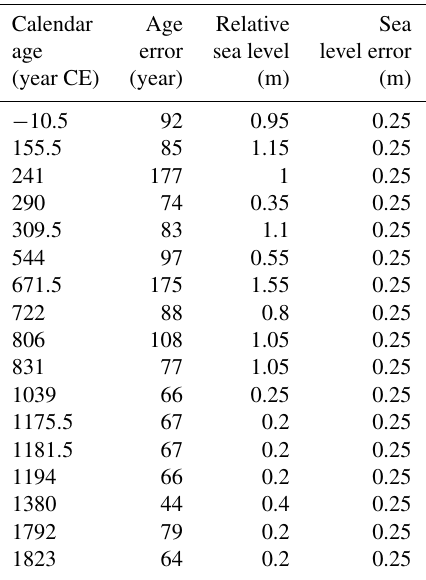
Table 3. Proxy sea-level reconstructions for the past 2 millennia from Santa Catarina (Milne et al., 2005). Milne et al. (2005) give calendar ages as min–max ranges, which I take to be 95% confi- dence intervals. I take the center point as the best estimate and one- quarter of the range as 1 standard error. I also assume that sea-level errors given by Milne et al. (2005) correspond to 2 standard errors.